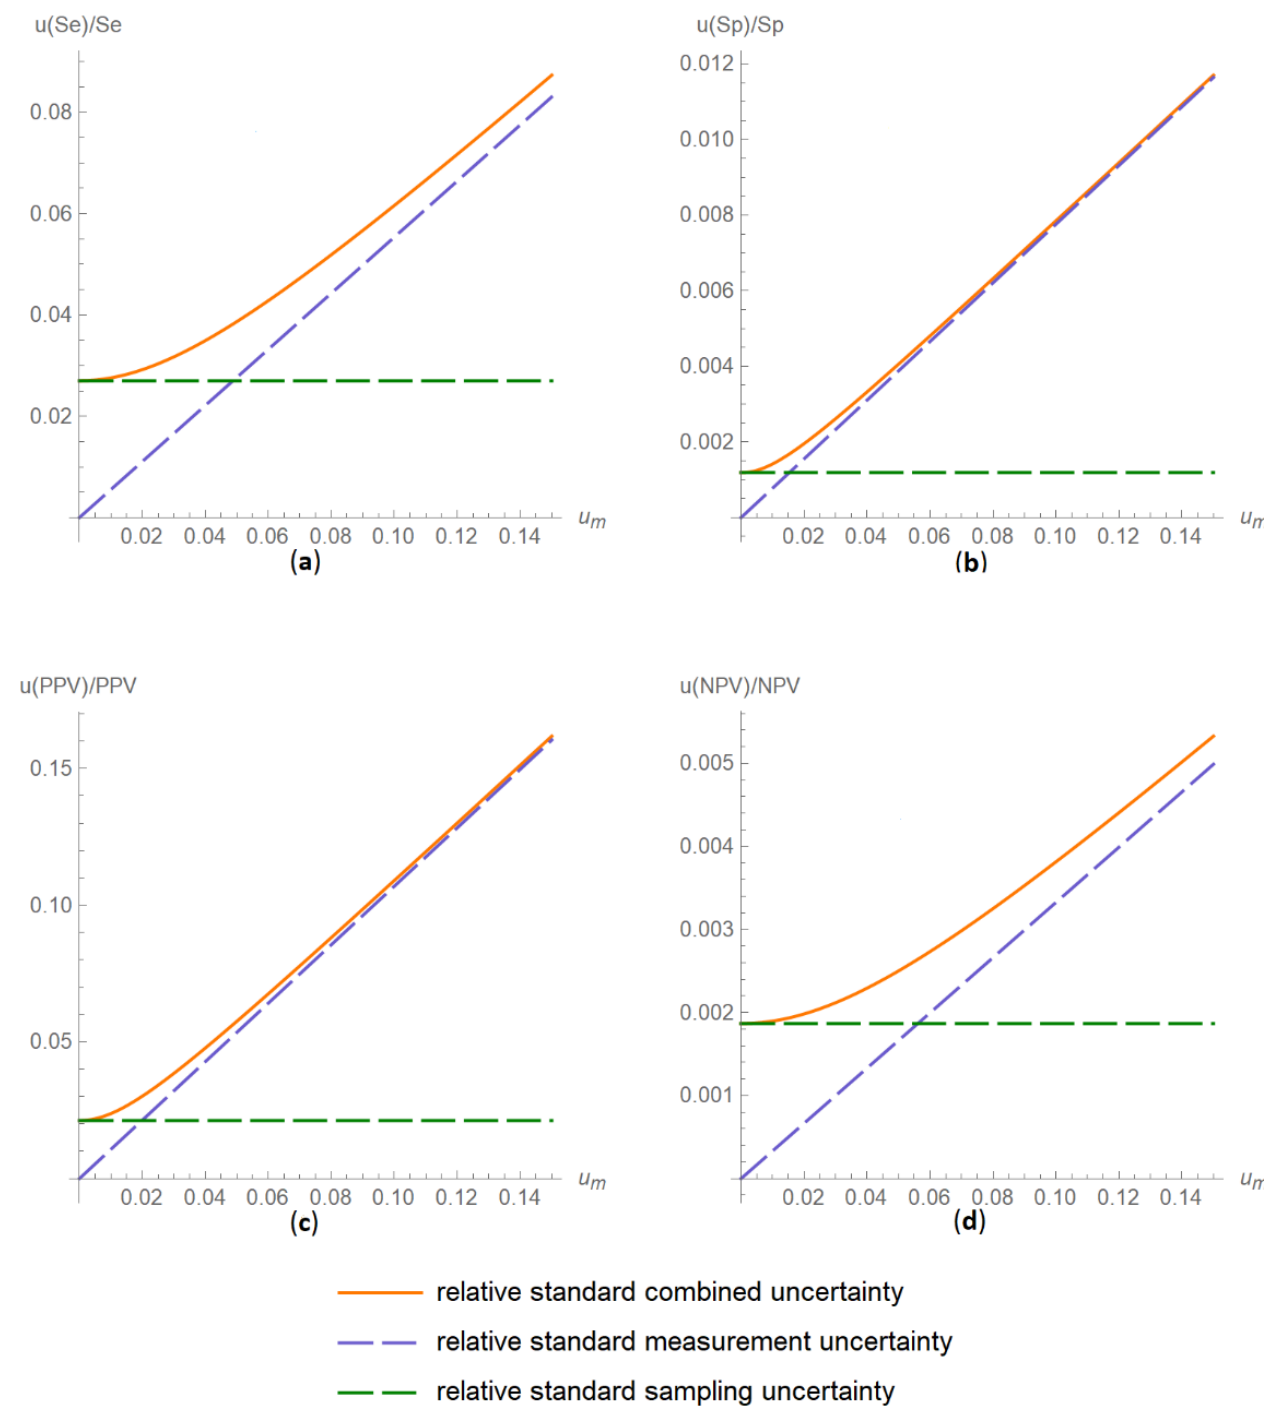
Figure 18. DAM confidence intervals versus diagnostic threshold plots. Plots of confidence intervals of ( a ) sensitivity ( Se ), Figure 18. DAM relative standard uncertainties versus measurement uncertainty plots. Plots of relative standard com- ( b ) specificity ( Sp ), ( c ) positive predictive value ( PPV ) and ( d ) negative predictive value ( NPV ) versus diagnostic threshold bined, measurement and sampling uncertainties of ( a ) sensitivity ( u(Se )/ Se ), ( b ) specificity ( u(Sp )/ Sp ), ( c ) positive predic- ( d ) curves, with the respective parameter settings in Table tive value ( u(PPV )/ PPV ) and ( d ) negative predictive value ( u(NPV )/ NPV ) versus standard measurement uncertainty ( u m ) curves, with the respective parameter settings in Table 4.